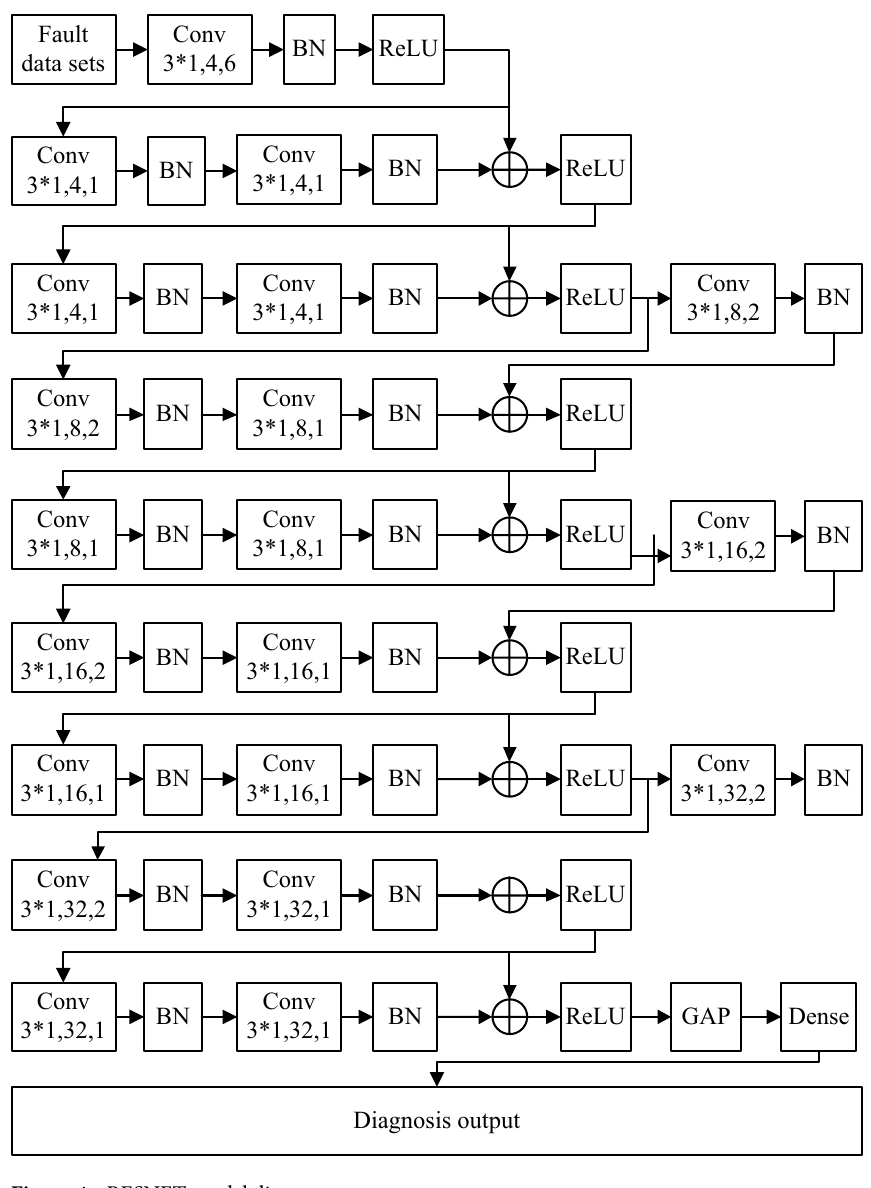
Figure 4. RESNET model